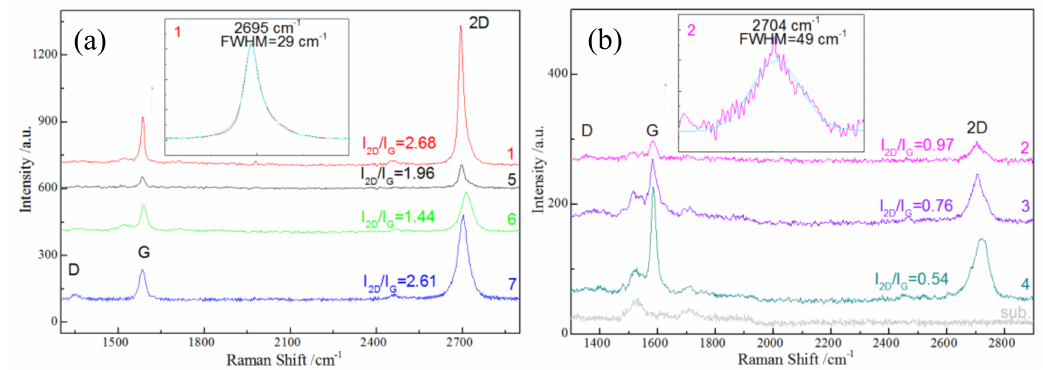
Figure 5. Raman spectra collected from points of surface of Wafer C2, marked in Figure